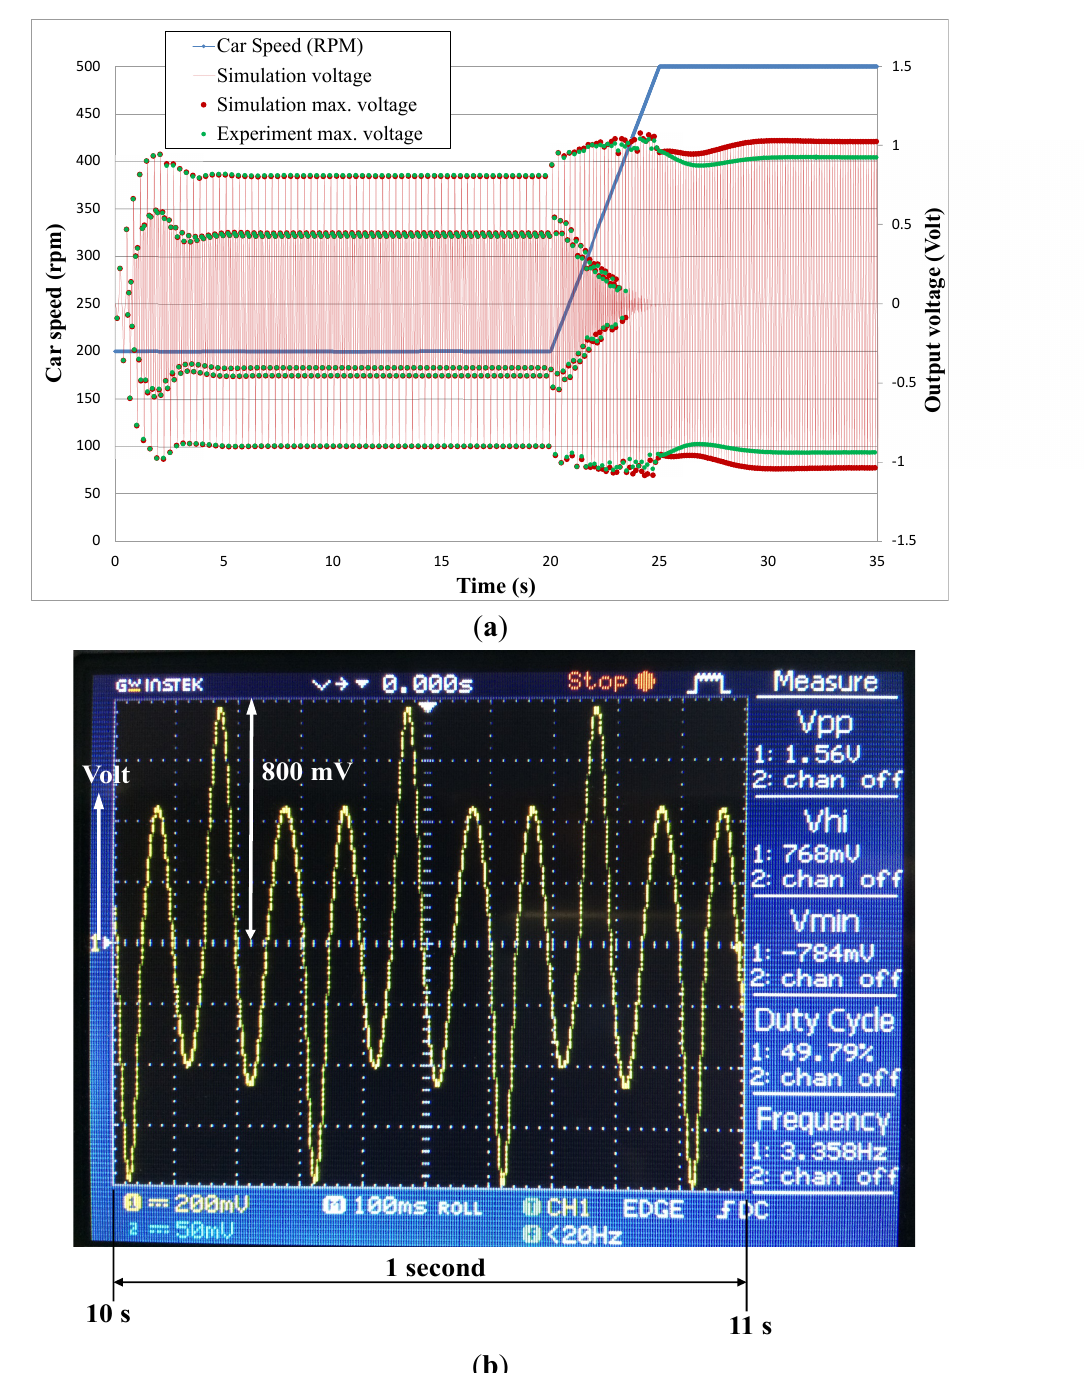
Figure 11. Instant output voltage of the WREH from 200 to 500 rpm. ( a ) Simulation and experimental results. ( b ) Experimental output voltage of the WREH from 10 to 11